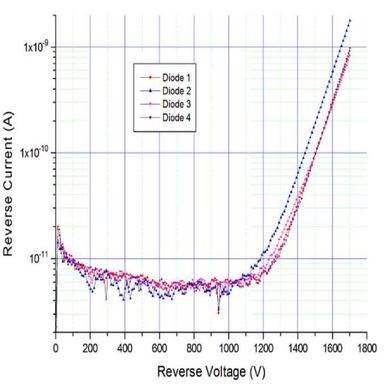
Characteristic of the reverse leakage current in the vacuum chamber. The measurements have been performed on 4 different samples of the same diode up to 1700 V.